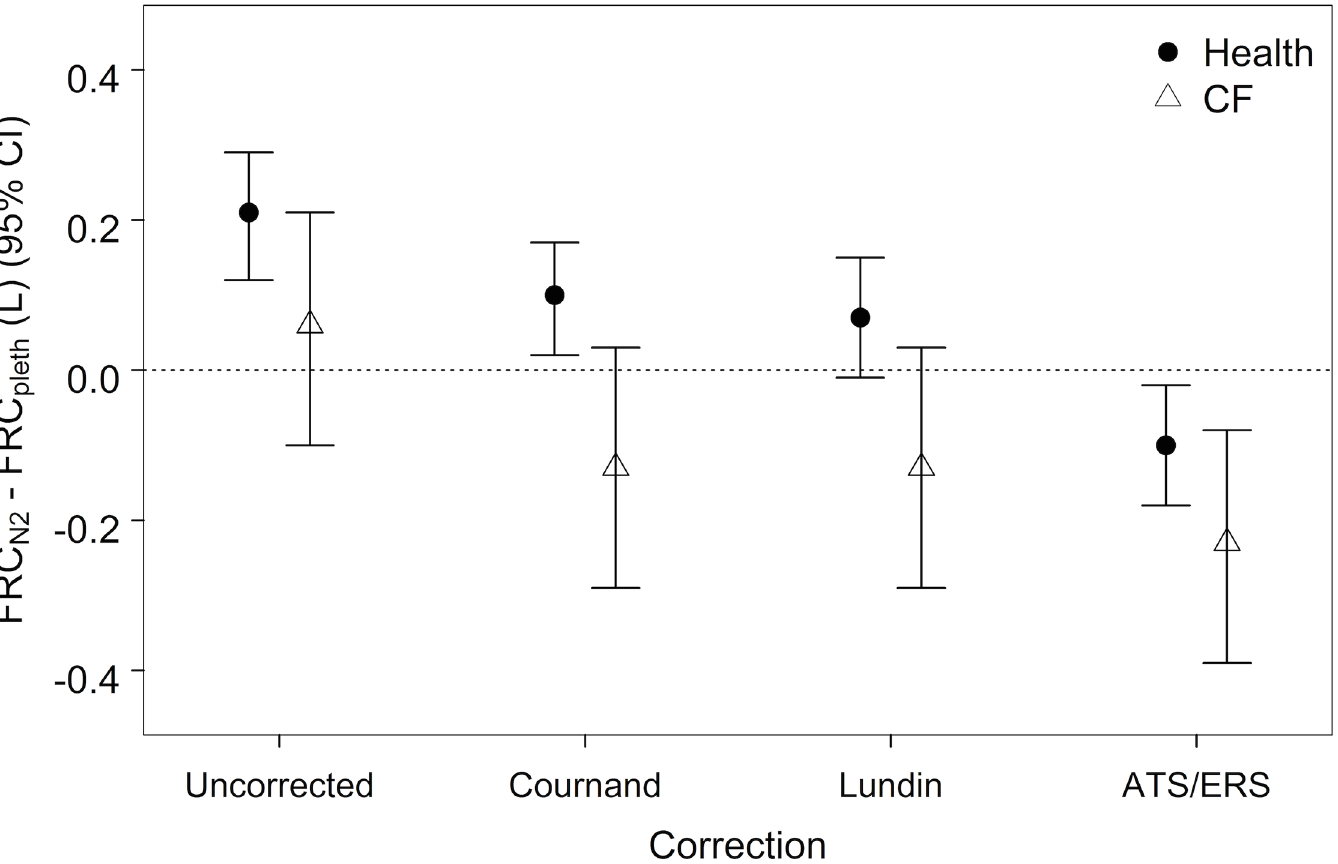
Fig 2. Within-subject difference in FRC measured by multiple breath nitrogen washout (FRC N2 ) and body plethysmography (FRC pleth ). The mean within-subject difference FRC N2 —FRC pleth decreased after the three tissue N 2 excretionequationswere appliedto washout data from healthyand CF populations.